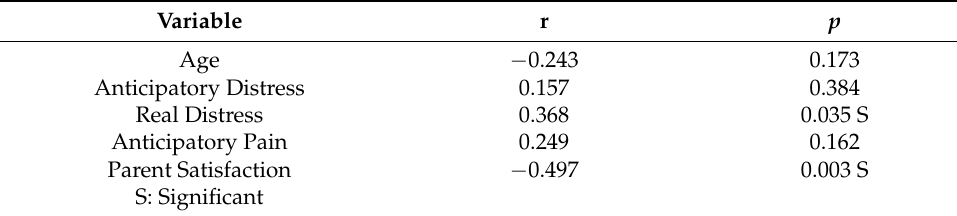
Table 4. Spearman’s correlation coefficient. Real